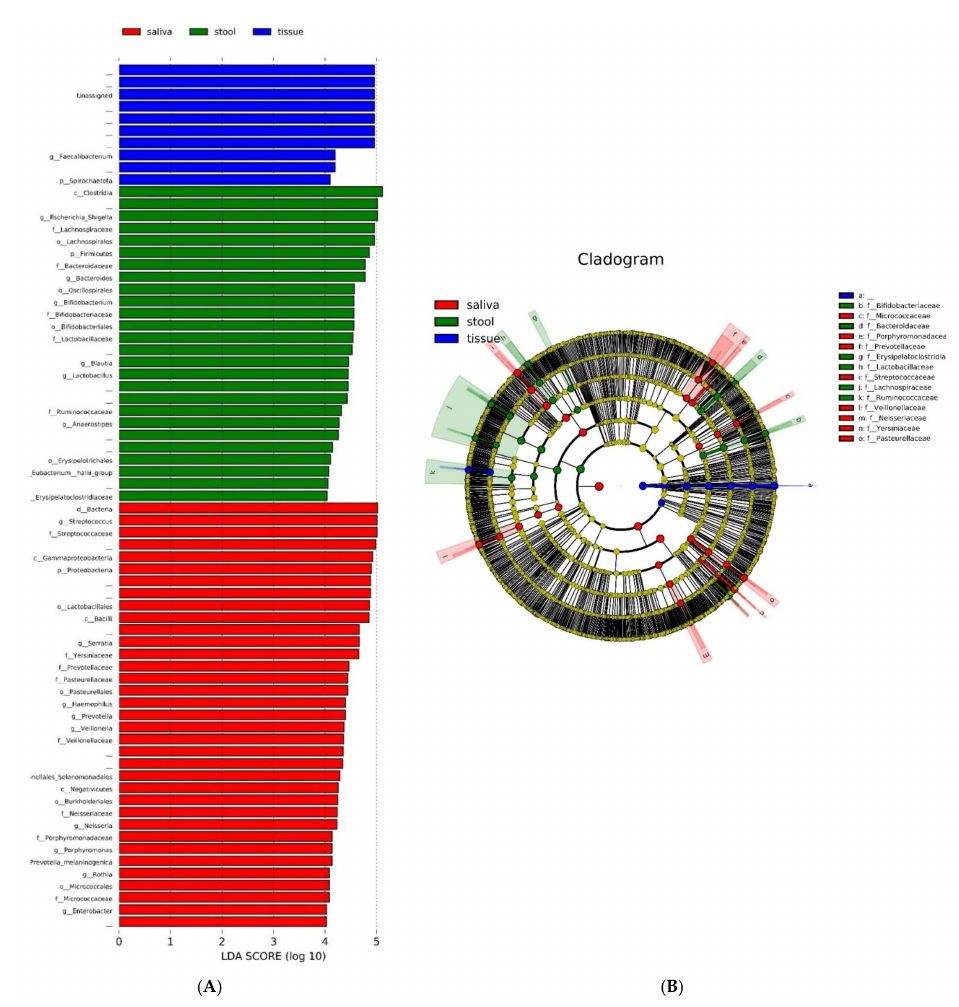
Figure 4. LDA histogram of the microbiome in the saliva, tissue, and stool samples of patients with CD ( A ) and a cladogram of the microbiome in the saliva, tissue, and stool samples of patients with CD ( B ). Streptococcus , Serratia , and Prevotella in saliva and Escherichia-Shigella and Bacteroides genera in stool were marked. These genera were also marked as representative identities for the